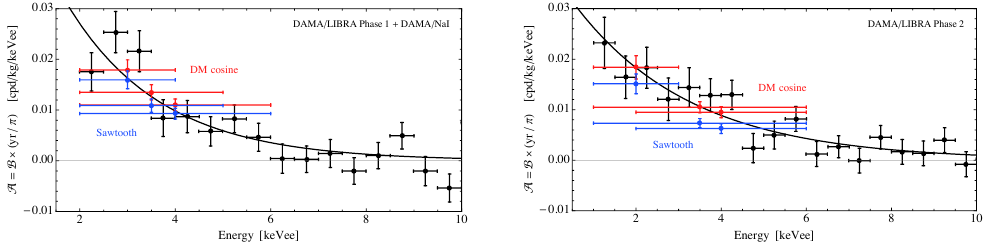
Figure 8 . Energy dependence of the modulated signal observed by DAMA . The black points are the amplitudes of the cosine signal reported by DAMA in 0.5 keVee energy bins [6]; for comparison we also show the DM cosine amplitudes in the wider energy intervals discussed above (red points), and our best-(cid:12)t values for a linearly growing background (blue points). The black curves (cid:12)t the data assuming an exponential energy dependence. Left: combination of DAMA/LIBRA Phase 1 and DAMA/ NaI. Right: DAMA/LIBRA Phase